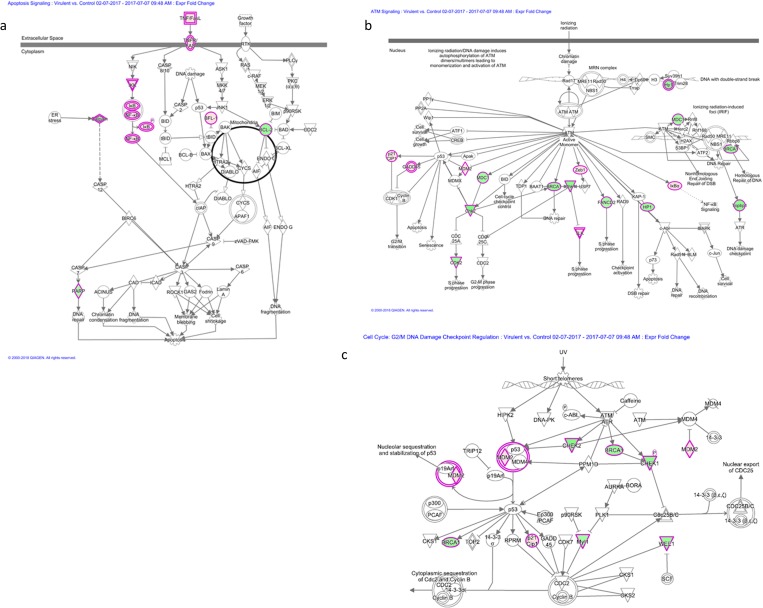
Canonical signaling pathway obtained by the IPA (Ingenuity Pathway Analysis software.Red and green indicate upregulated and down-regulated genes, respectively, compared to control group, and belongs to datasets of DEGs virulent vs. control assays. Color intensity corresponds to the degree of up or downregulation (fold-change). White represents the known genes of the pathway without identification in the transcriptomic analysis. Panel A) Canonical signaling pathway of Apoptosis of in vitro macrophages. Panel B) Canonical signaling of ATM of in vitro macrophages. Panel C) Canonical signaling pathway of Cell Cycle: G2 / M DNA Damage Checkpoint Regulation of in vitro macrophages.